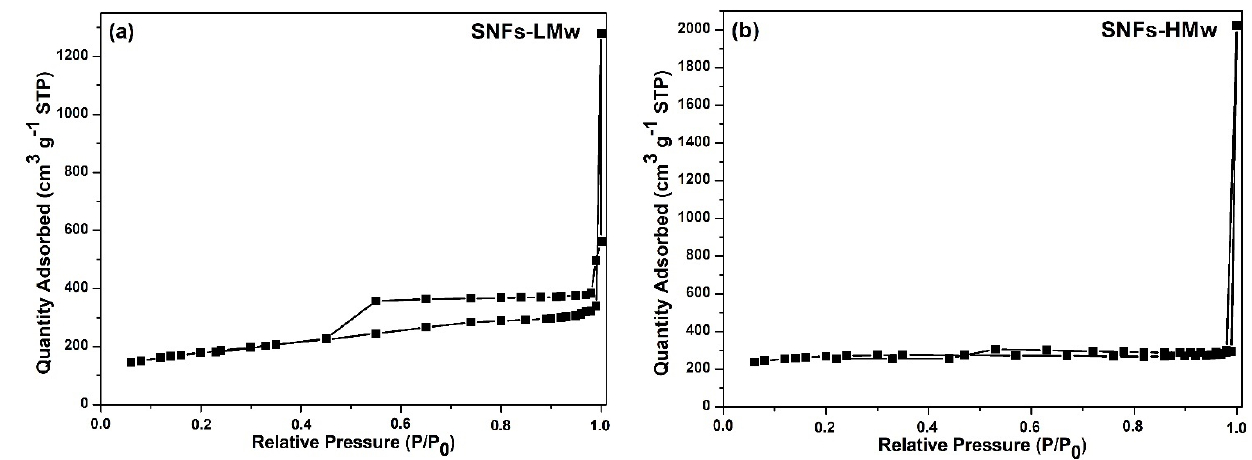
Figure 4. N 2 adsorption–desorption isotherm of: ( a ) SNFs-LMw and ( b ) SNFs-HMw.